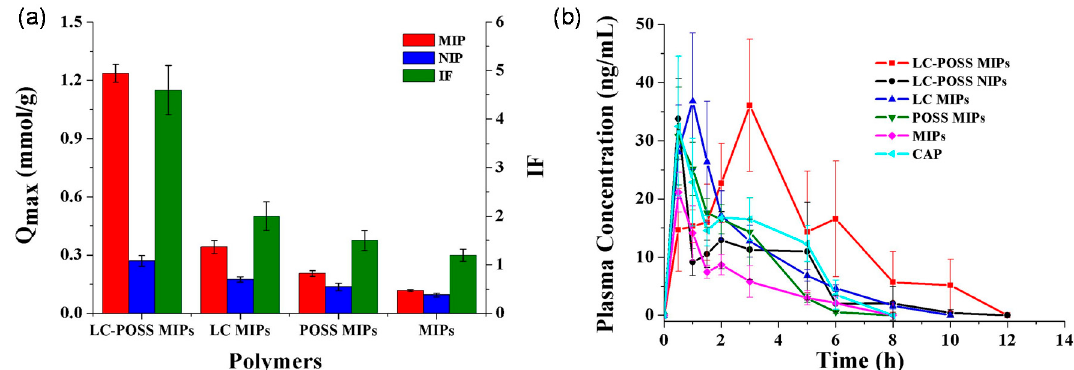
Figure 6. ( a ) Effects of POSS and LC on the absorptive capacity; ( b ) Plasma concentration-time curves of the loaded LC-POSS MIPs, LC-POSS NIPs, LC MIPs, POSS MIPs, MIPs and the commercial tablet of CAP. Each data point represents the mean ± standard deviation (n = 3). Adapted with permission from Mo et al. [104].